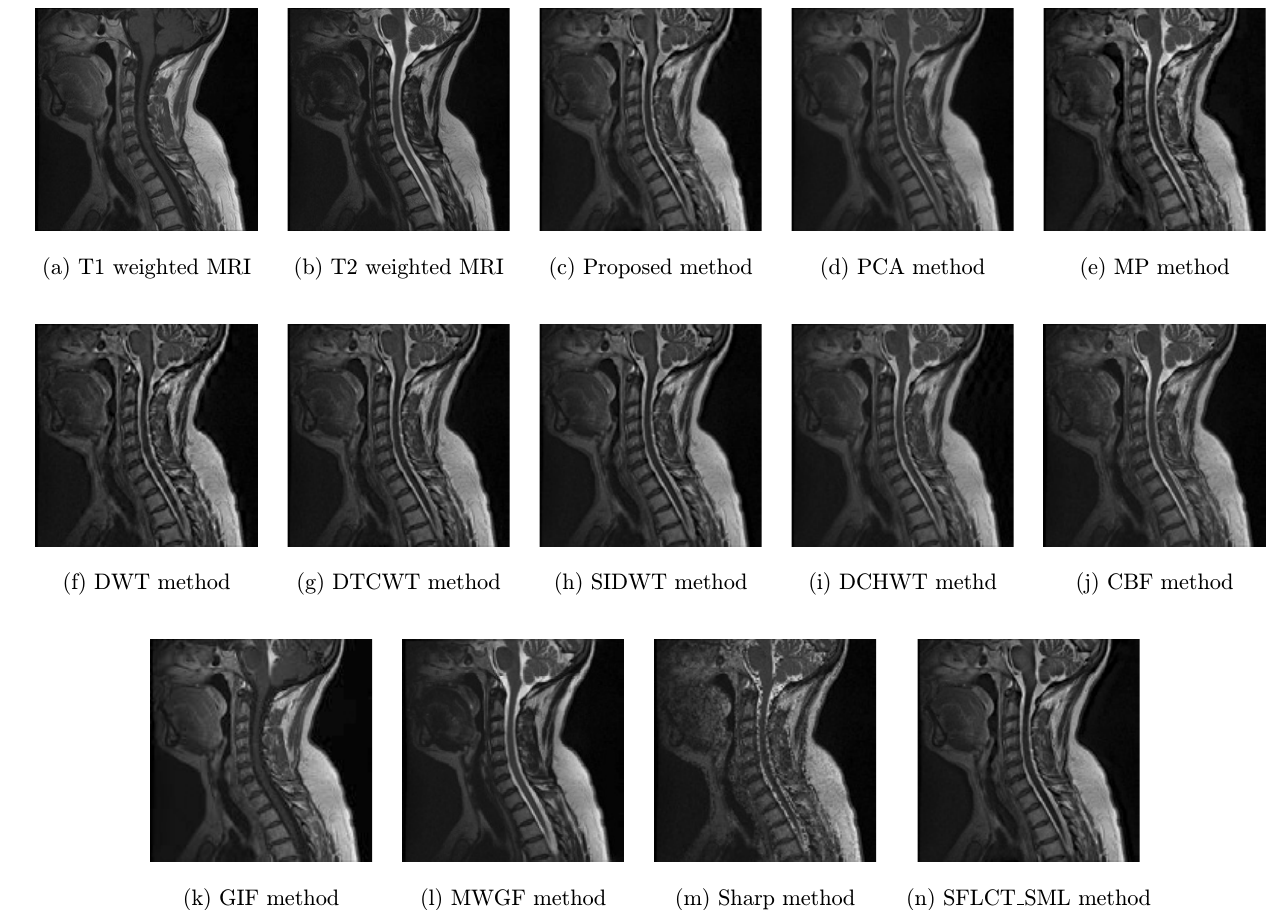
Fig. 6. Fused images for the third group of medical images.